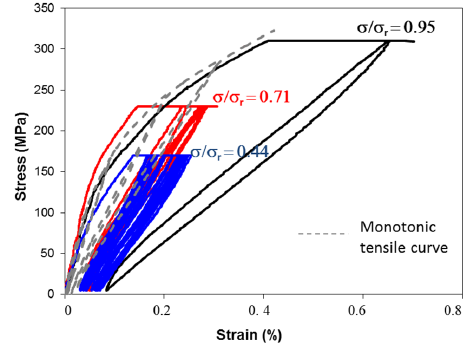
Figure 4. Stress versus strain during static fatigue experiments for different σ / σ R ratios: 0.44, 0.71 and 0.95 at 500 °C on SiC f /[Si-B-C] composites. The grey curve represents the monotonic tensile curve.